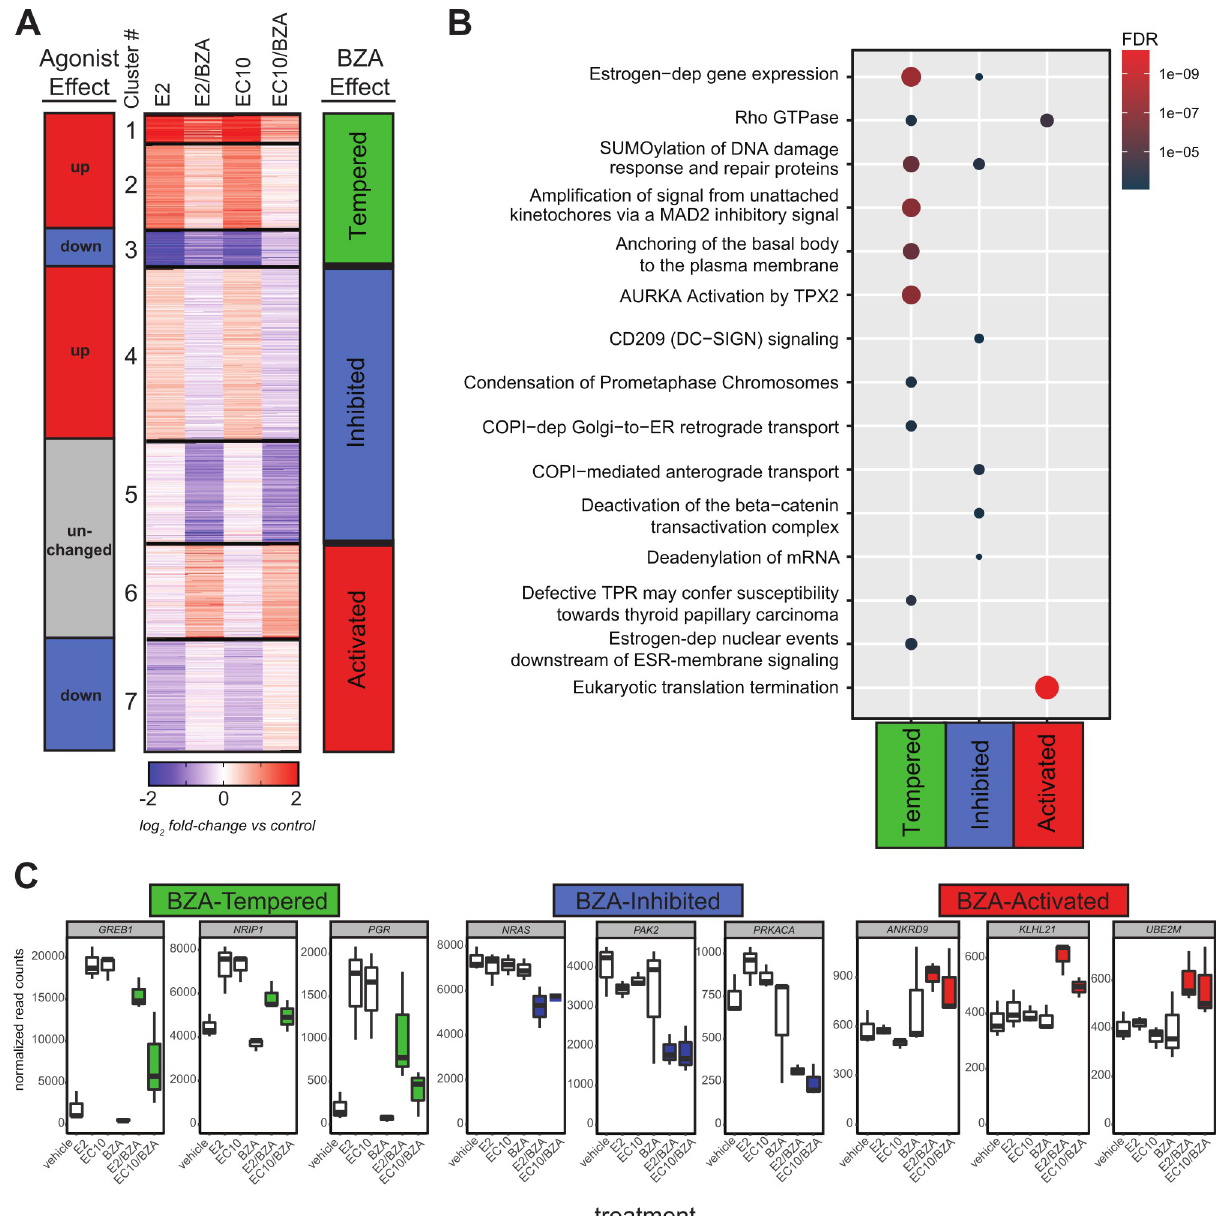
Fig 2. BZA alters steroid responsiveness in the MCF7 cell line. A) Clustering analysis of 2,332 genes comparing BZA-induced changes in E2 or EC10 responses. There are seven distinct clusters that group into different agonist effect groups (E2 or EC10) or into three different BZA-effect groups (Tempered, Inhibited, Activated) based on the effect of BZA on agonist responses. B) Reactome pathway enrichment analysis of BZA-effect groups from Fig 2A. The top enriched Reactome gene sets are shown in dot plot, where each dot is an enriched gene set, the color represents the significance, and the size signifies the gene set size. C) Normalized RNA-seq expression values of selected genes from each BZA-effect group (Tempered, Inhibited, Activated). Data shown are from MCF7 RNA-seq DESeq2-normalized read counts from each treatment group (n = 3 replicates per group). The E2/BZA and EC10/BZA treatments are color-coded according to the BZA-effect groups from Fig 2A. start sites (TSSs) across all protein-coding genes (Fig 3 and S3 Fig). For example, for clusters 1–6 there is a shift from state 6 (poised) in MCF10A to state 5 (active) in MCF7. Further, there is a shift in cluster 14 from state 2 (repression) in MCF10A to state 4 (low signal) in MCF7,